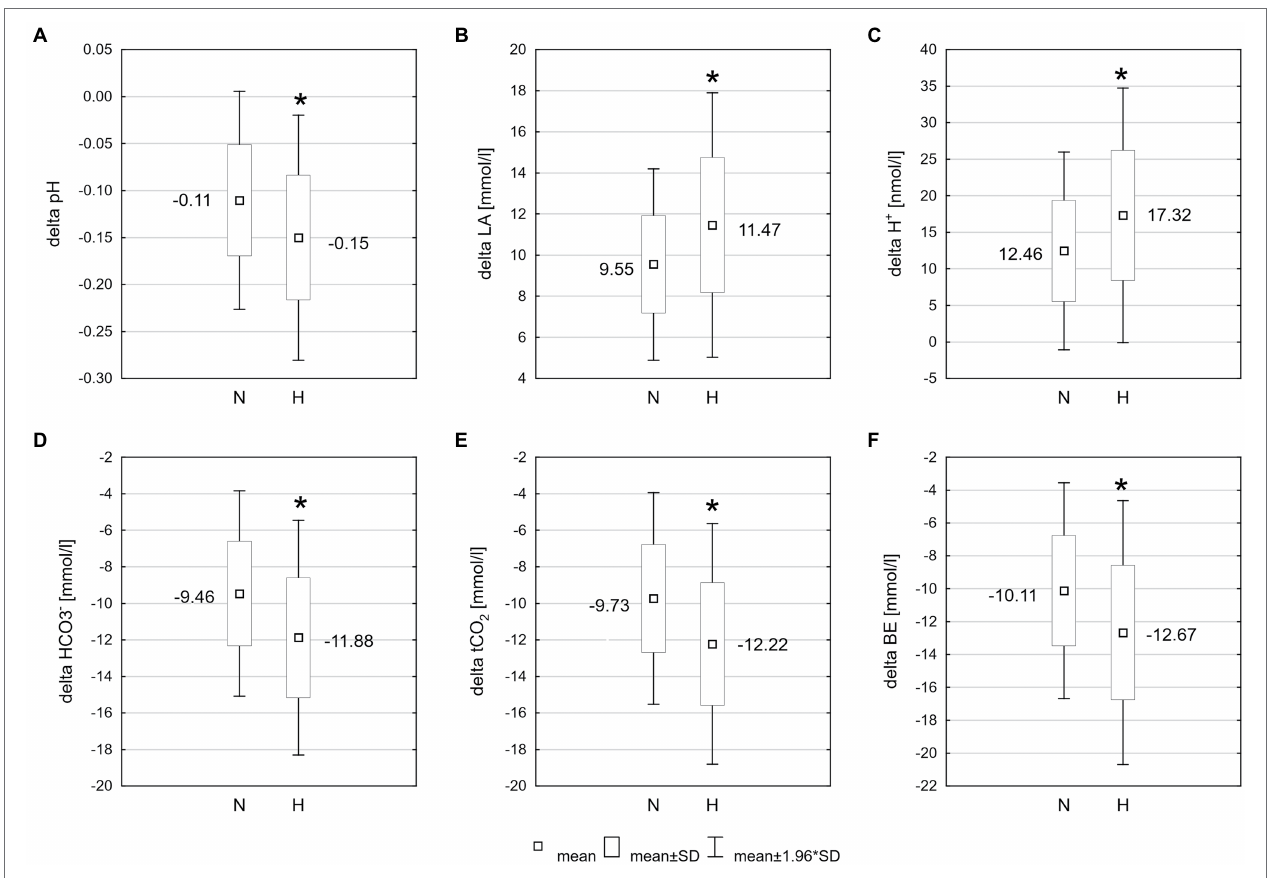
FIGURE 3 | Changes of acid–base balance following 30 km time trial in normoxia (N) and hypoxia (H). * p < 0.05 – significant differences between N and H; (A) delta pH – blood pH changes after exercise, (B) delta LA – change in blood lactate concentration, (C) delta H + − change in hydrogen ion